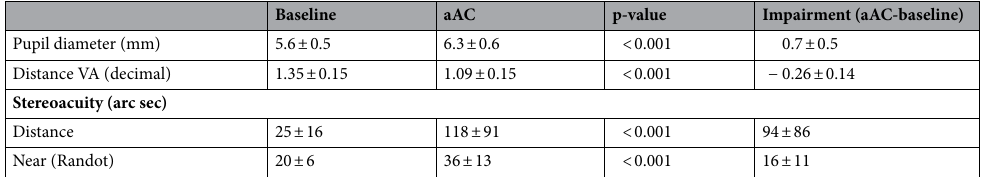
Table 1. Mean and standard deviations of pupil diameter and binocular vision function parameters (distance visual acuity and stereopsis) measured at baseline and after alcohol consumption (aAC) giving a BrAC of 0.40 mg/l. Mean impairment values for each parameter are included (calculated as the mean difference between aAC and baseline